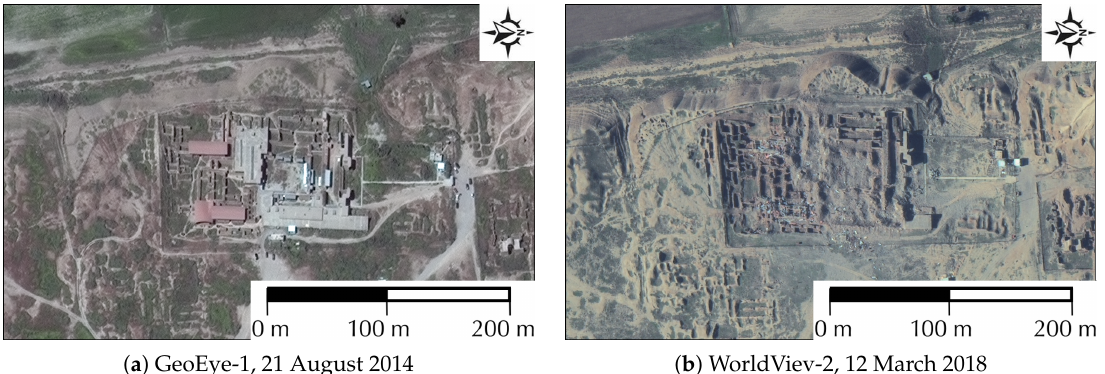
Figure 4. Destruction damage type related to demolition. The northwest palace of Nimrud had an interpretation center and protective structures that have been demolished c (cid:13) DigitalGlobe.